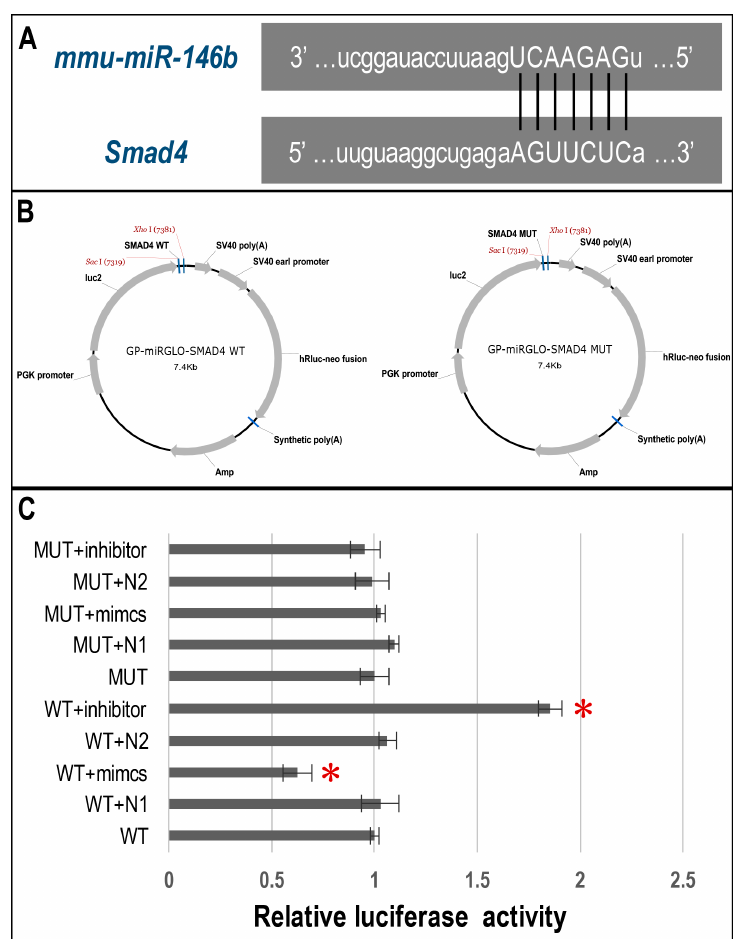
Figure 4. Dual-luciferase reporter assay of the direct binding of miR-146b-5p on the 3 ′ UTR of Smad4. ( A ) Bioinformatics analyses showed that miR-146b-5p was complementary to a sequence in the Smad4 3 ′ UTR; ( B ) The structure of pmirGLO-Smad4 3 ′ UTR-wild type (pmirGLO-Smad4-WT) and pmirGLO-Smad4 3 ′ UTR-mutation (pmirGLO-Smad4-MUT) luciferase reporter plasmids; ( C ) The pmirGLO-Smad4-WT and pmirGLO-Smad4-MUT reporter construct s were co-transfected with miR-146b-5p mimics, miR-146b-5p inhibitor and the negative control into 293 T cells. Co-transfection of pmirGLO-Smad4-WT with miR-146b-5p (WT + mimics) resulted in a significant reduction in the